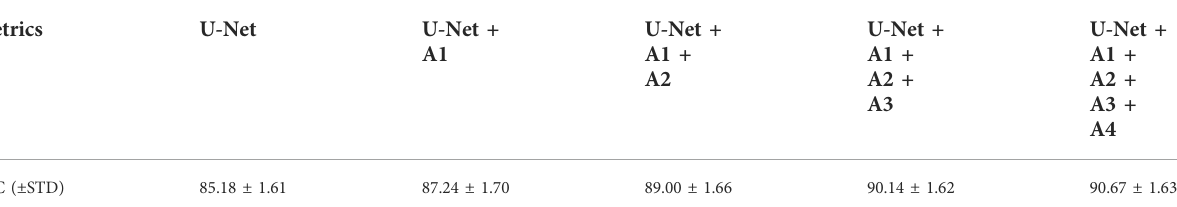
TABLE 1 Performance improvement of the model after the stacking of different modules (%).